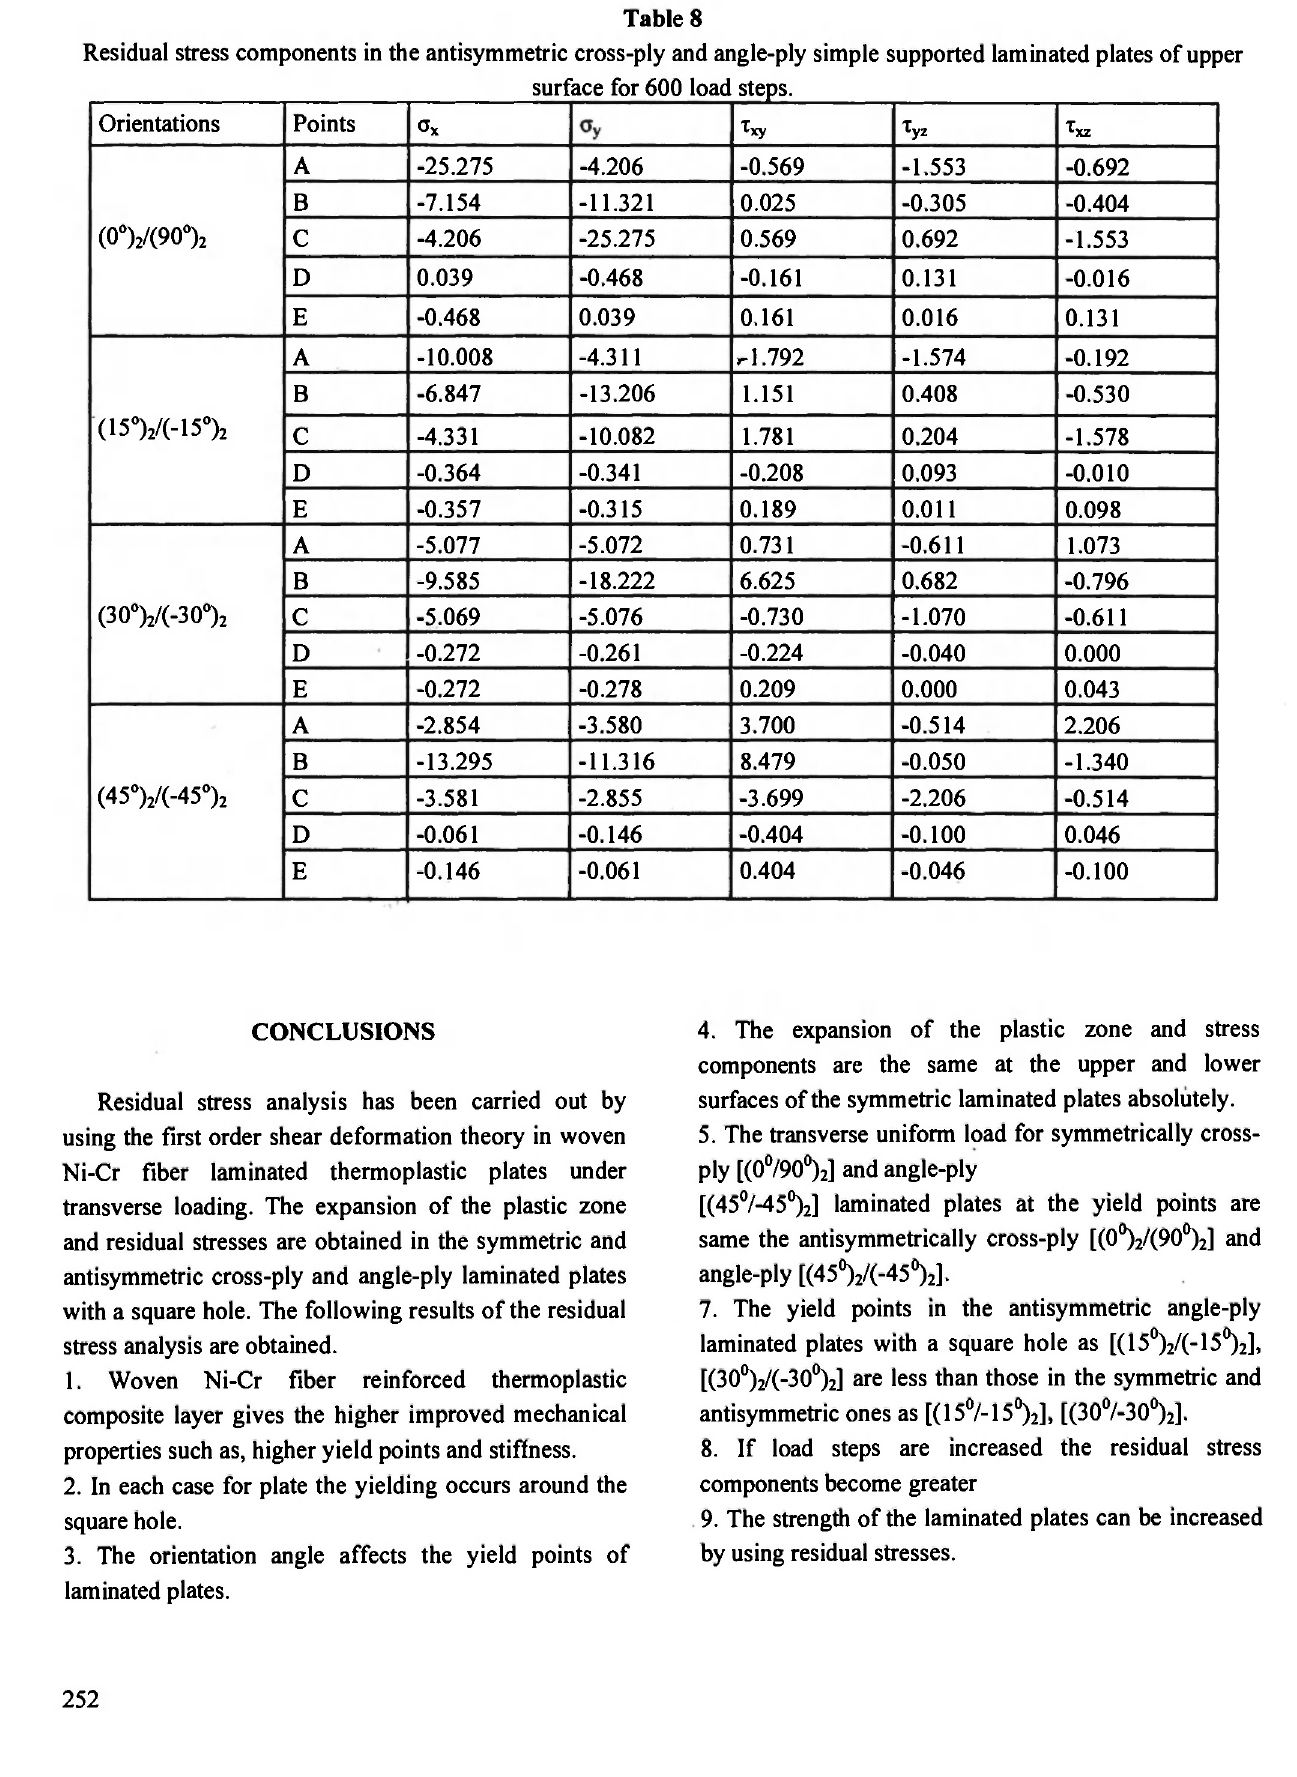
Residual stress components in the antisymmetric cross-ply and angle-ply simple supported laminated plates of upper surface for 600 load